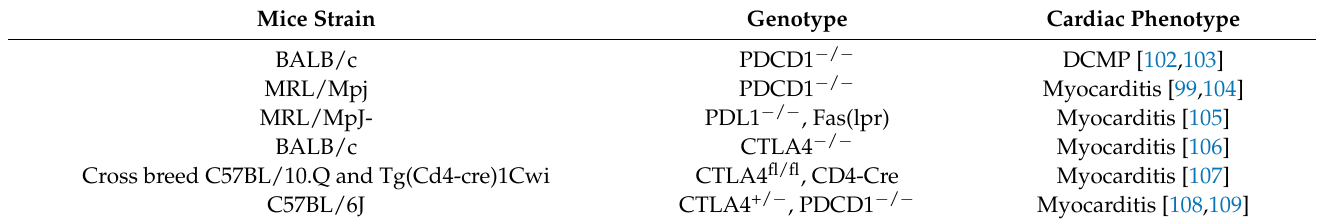
Table 3. Transgenic Mice for Immune Checkpoint Inhibitor-induced